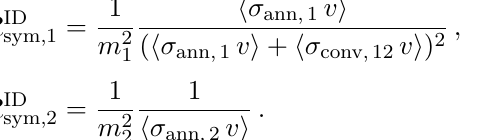
Figure 11 . Abundance of the heaviest ( left panel ) and the lightest component ( right panel ) for different values of annihilation cross-sections in the light mediator case for N = 2 , m and m = 1000 GeV 2